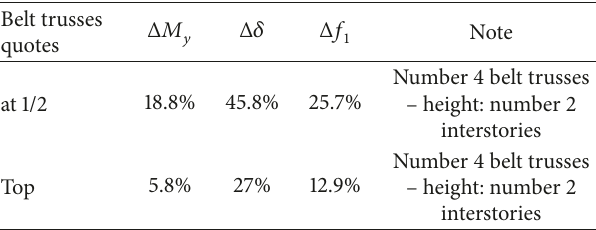
Table9:Comparisonbetweentheoriginalbuildingandthesolution proposed in Case 2, n. 2 interstory in height and n. 4 lines in horizontal length: Case